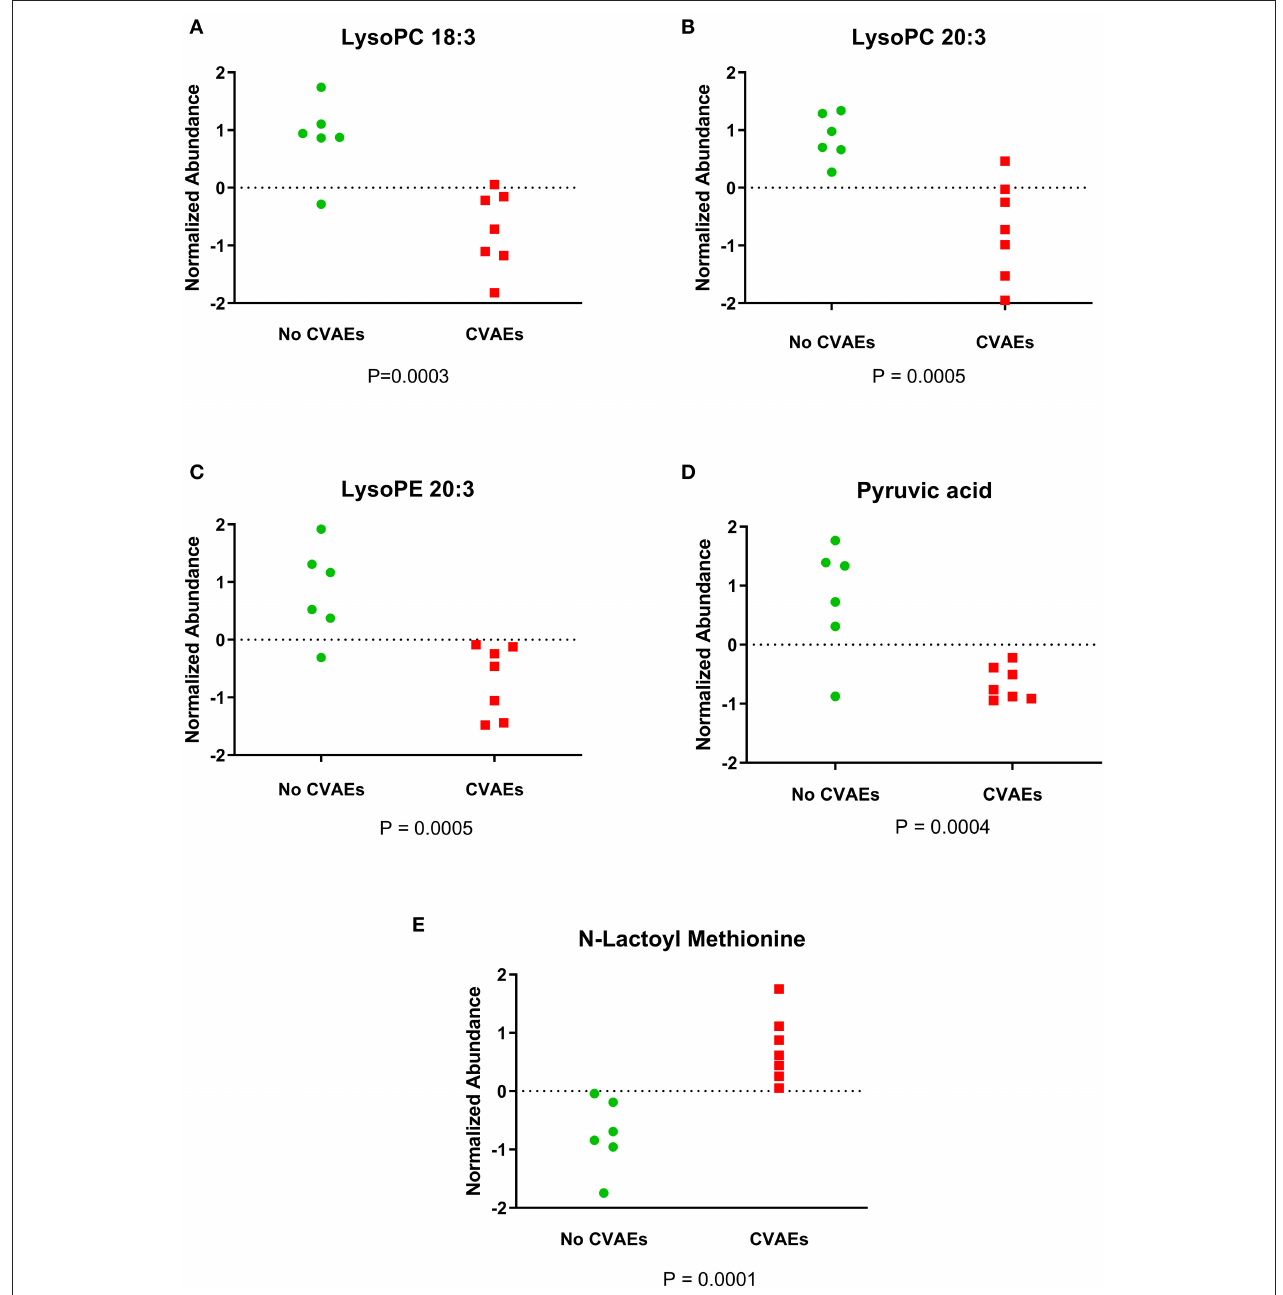
FIGURE 2 | Figure showing the normalized abundance of metabolites with significantly different levels between patients with and without CVAEs after treatment with CFZ. (A) LysoPC 18:3, (B) LysoPC 20:3, (C) LysoPE 20:3, (D) pyruvic acid, (E) N-lactoyl